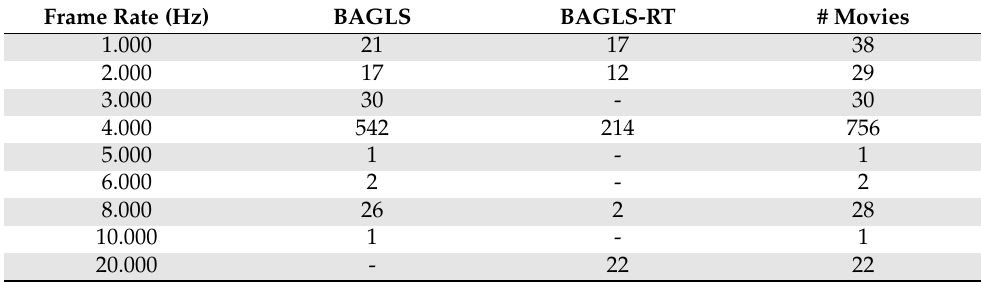
Table A1. Framerates and corresponding number of HSV movies in BAGLS and BAGLS-RT.